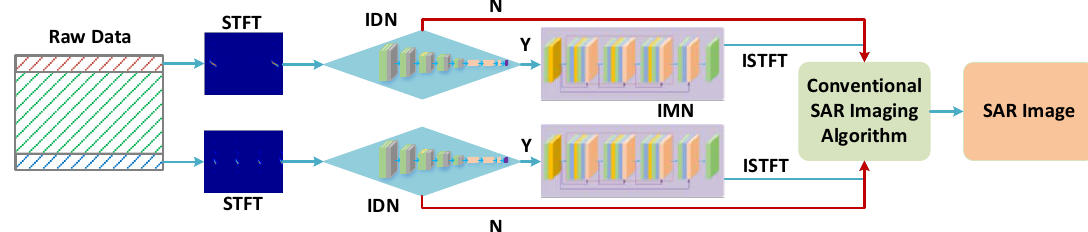
Figure 6. Workflow of the interference detection and mitigation based on a deep convolutional neural network (DCNN).